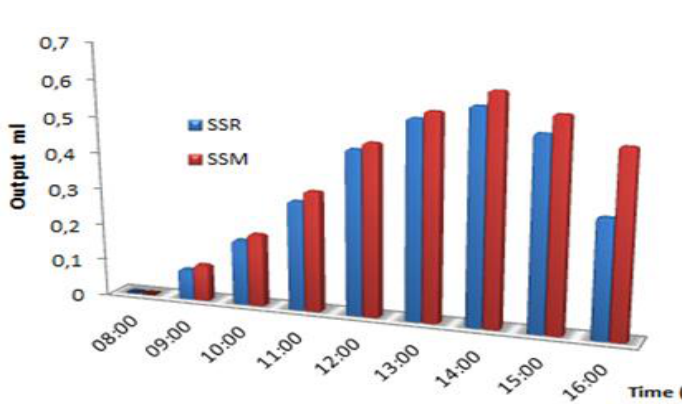
Figure 6. Accumulation output of pure water